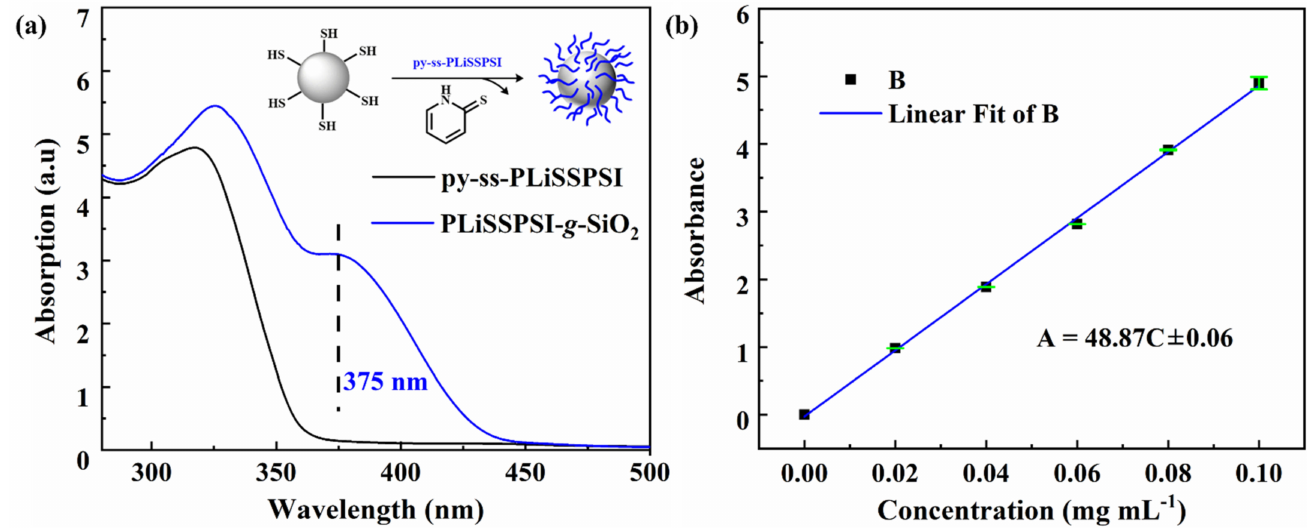
Figure 1. ( a ) Absorptions of pyridine-2-thione yielded in the thiol-disulfide exchange reaction between SiO 2 -SH and py-ss-PLiSSPSI in DMF and ( b ) standard curve of pyridine-2-thione in DMF. FT-IR spectra of SiO 2 -SH, py-ss-PLiSSPSI and PLiSSPSI- g -SiO 2 are presented in Figure